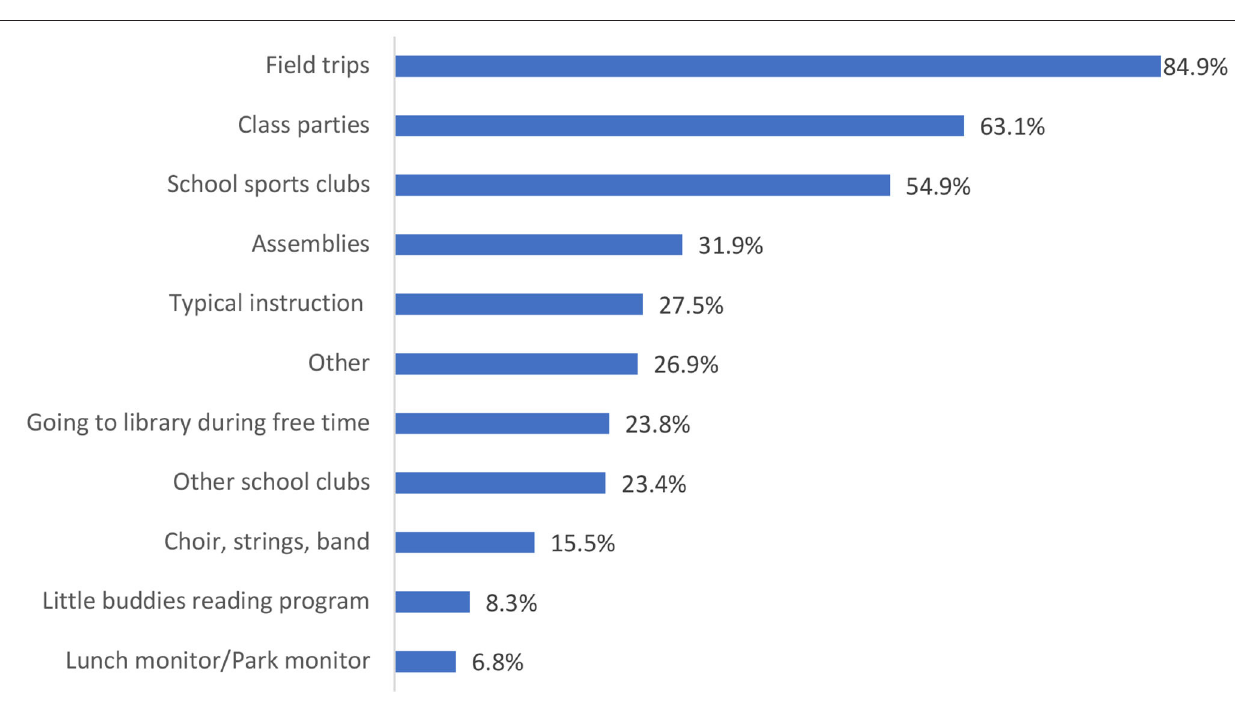
At the time of data collection, schools were in session but several restrictions were in place including canceled group activities, and learning within small working groups (29). When asked what students missed most at school during the COVID- 19 pandemic, the most frequent response was field trips (85%), followed by class parties (63%), school sports clubs (55%), assemblies (32%), and typical instruction (28%) ( Figure 4